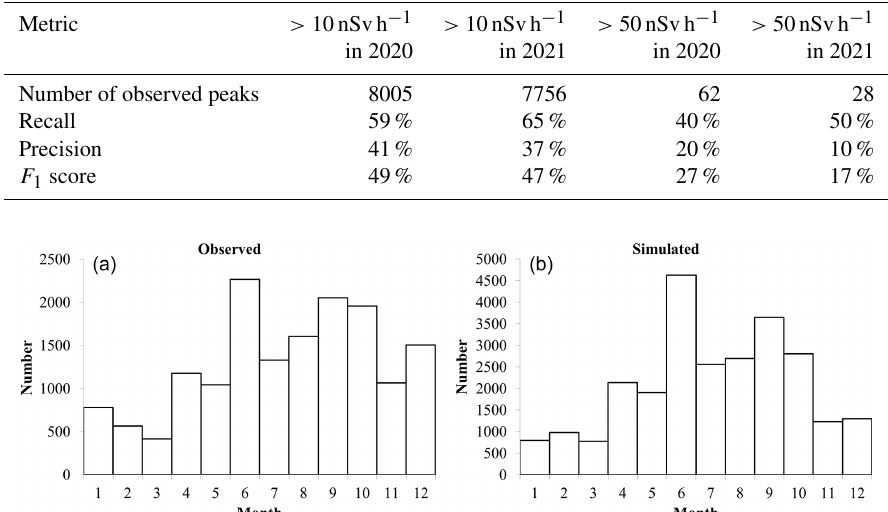
Table 5. Statistics for peaks greater than 10 and 50nSvh − 1 for 2020 and 2021, without the outliers.